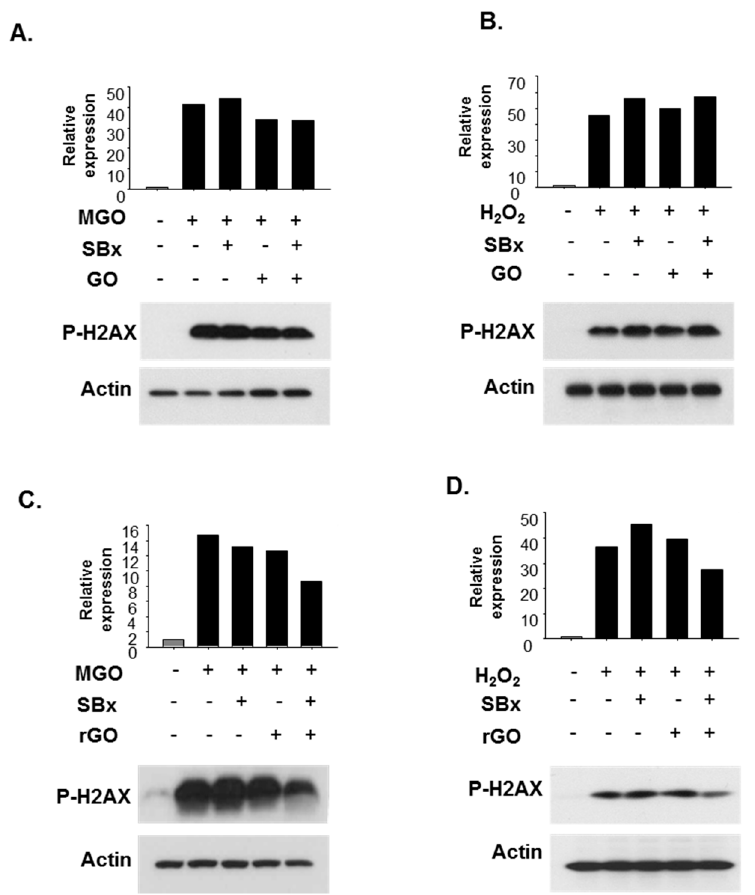
Figure 4. Effect of graphene oxide (GO) and reduced graphene oxide (rGO) with or without soybean extract (SBx) on phosphorylated H2AX protein levels in B3 cells. B3 cells were pretreated with SBx (10 μ g/mL) in the presence of GO (10 μ g/mL) ( A , B ) or rGO (10 μ g/mL) ( C , D ) for 48 h then 1 mM of MGO ( A , C ) and 100 μ M of H 2 O 2 ( B , D ) was added to the cells for 2 h. Phosphorylated H2AX protein levels were determined using Western blotting, and β -actin was used as the loading control.